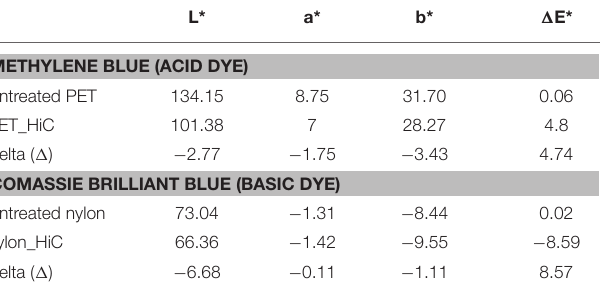
with a 10 mm² Apollo X Silicon Drift Detector by EDAX Ametek, NJ. USA, and Genesis Software V 6.53 from 21 September,